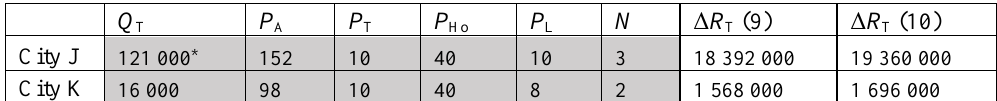
from Tourism Clusters T